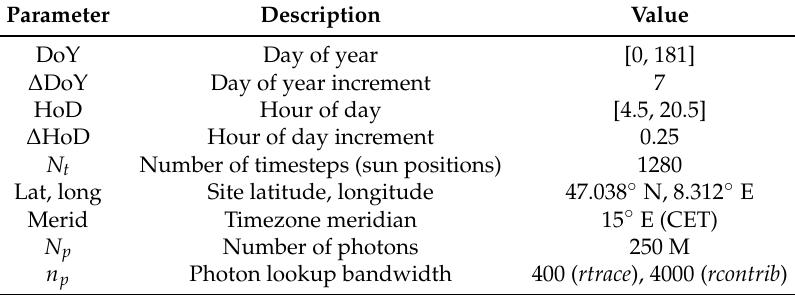
Table 3. Simulation parameters for PV reflection case